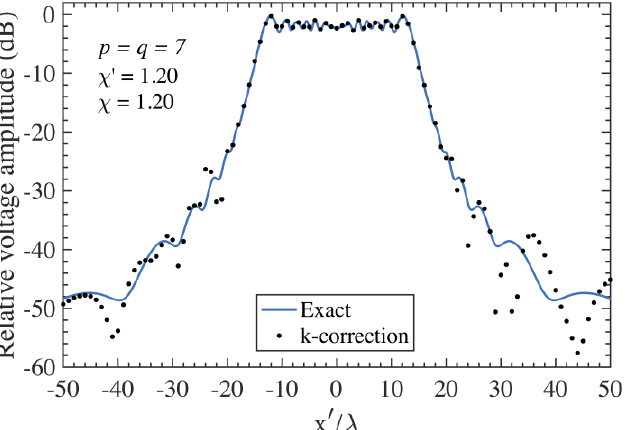
Figure 7. Amplitude of V y on the scanning plane at y (cid:48) = 3 λ − AUT 1. Blue line: exact. Black dots: attained from the positioning errors affected PWMS samples by using only the k-correction .